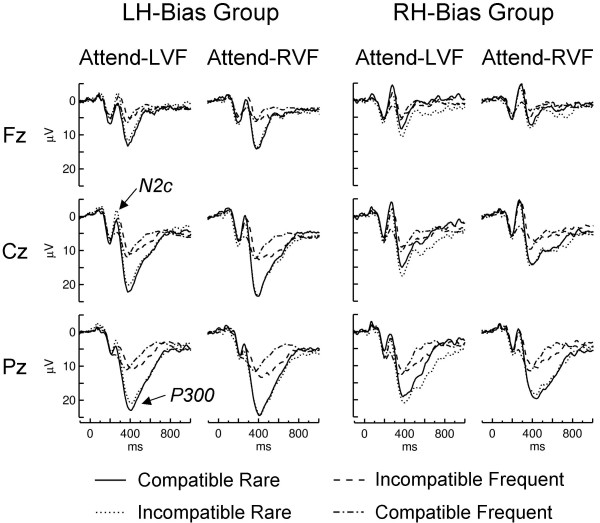
Grand average ERPs (whole epoch). ERPs in each condition at electrodes Fz, Cz, and Pz are shown for the LH-Bias and RH-Bias groups. The N2c and P300 components are indicated.